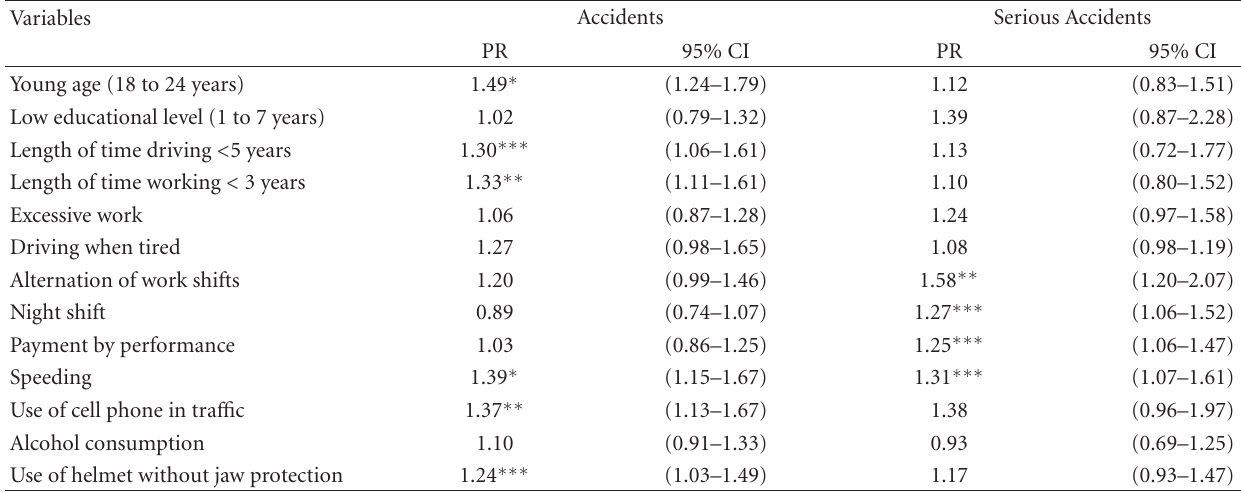
Table 2: Association between characteristics of the motorcycle couriers and reports of road accidents and serious accidents: prevalence ratio, PR (95% CI).